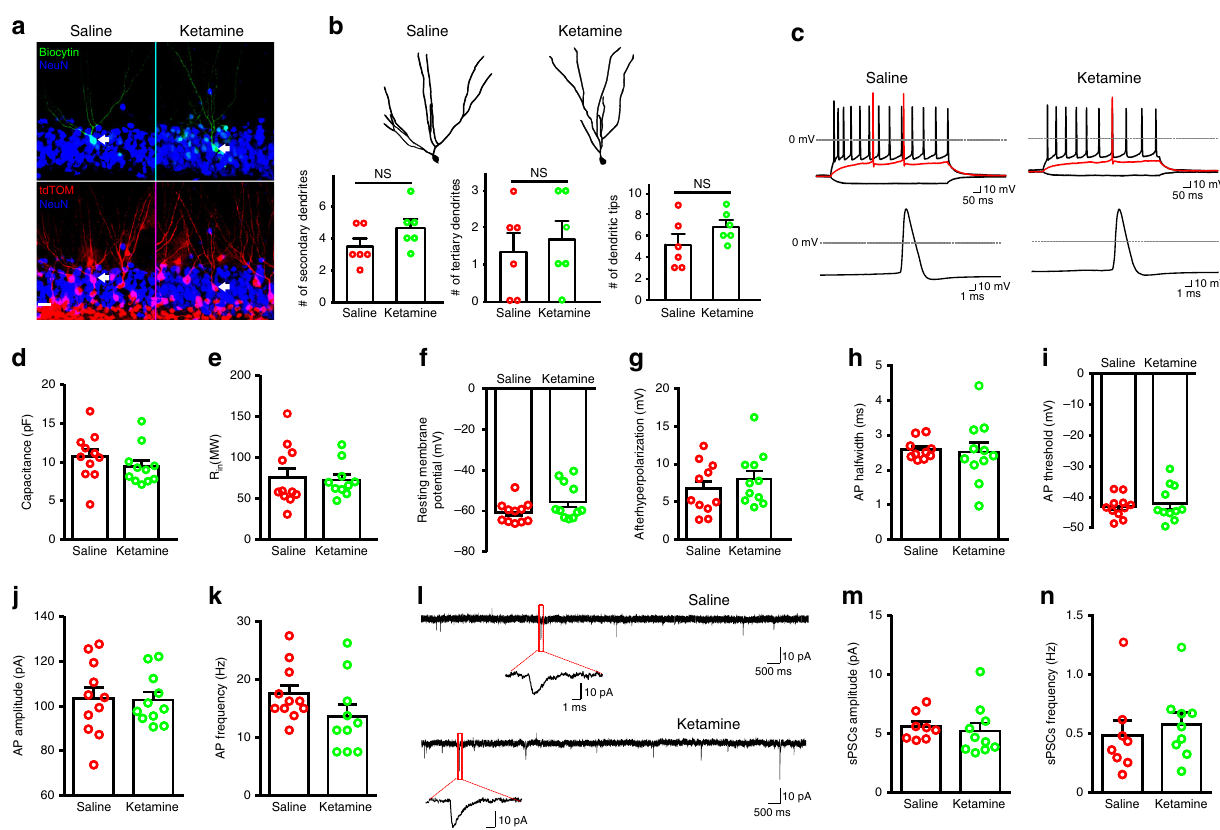
Fig. 2 Electrophysiology properties of newly differentiated neurons. a Representative morphology of patched newborn neurons (NeuN, blue) fi lled with biocytin (green) and traced by tdTomato (tdTOM, red). Scale bar, 20 µ m. b Tracing of representative neurons shown in a and the quanti fi cation of secondary ( p = 0.1504) and tertiary ( p = 0.6438) dendrite number as well as the number of dendritic tips ( p = 0.1778) ( n = 6 per group; not signi fi cant (NS) for all comparisons by unpaired two-tailed t -test). c Representative action potential (AP) waveforms recorded under current-clamp mode from patched neurons. The precondition sweep and sweeps immediately above threshold (red trace) and at the highest frequency are shown in the upper panel, and a single AP spike is shown in the lower panel. d A plot of neuron capacitance under saline or ketamine ( n = 11 per group; p = 0.3112 by unpaired two- tailed t -test). e A plot of neuron input resistance under saline or ketamine (saline, n = 11; ketamine, n = 10; p = 0.5573 by Mann – Whitney test). f A plot of neuron resting membrane potential under saline or ketamine ( n = 11 per group; p = 0.1874 by Mann – Whitney test). g A plot of neuron after- hyperpolarization (AHP) under saline or ketamine ( n = 11 per group; p = 0.3936 by unpaired two-tailed t -test). h A plot of neuron AP half width under saline or ketamine (saline, n = 10; ketamine, n = 11; p = 0.8284 by unpaired two-tailed t -test). i A plot of neuron AP threshold under saline or ketamine ( n = 11 per group; p = 0.8284 by unpaired two-tailed t -test). j A plot of neuron AP amplitude under saline or ketamine ( n = 11 per group; p = 0.9170 by unpaired two-tailed t -test). k A plot of neuron AP frequency under saline or ketamine (saline, n = 11; ketamine, n = 10; p = 0.1305 by unpaired two-tailed t -test). l Representative traces of spontaneous postsynaptic currents (sPSCs) recorded from differentiated neurons are shown. m A plot of neuron sPSCs amplitude under saline or ketamine (saline, n = 8; ketamine, n = 10; p = 0.3154 by Mann – Whitney test). n A plot of neuron sPSCs frequency under saline or ketamine (saline, n = 8; ketamine, n = 9; p = 0.3213 by Mann – Whitney